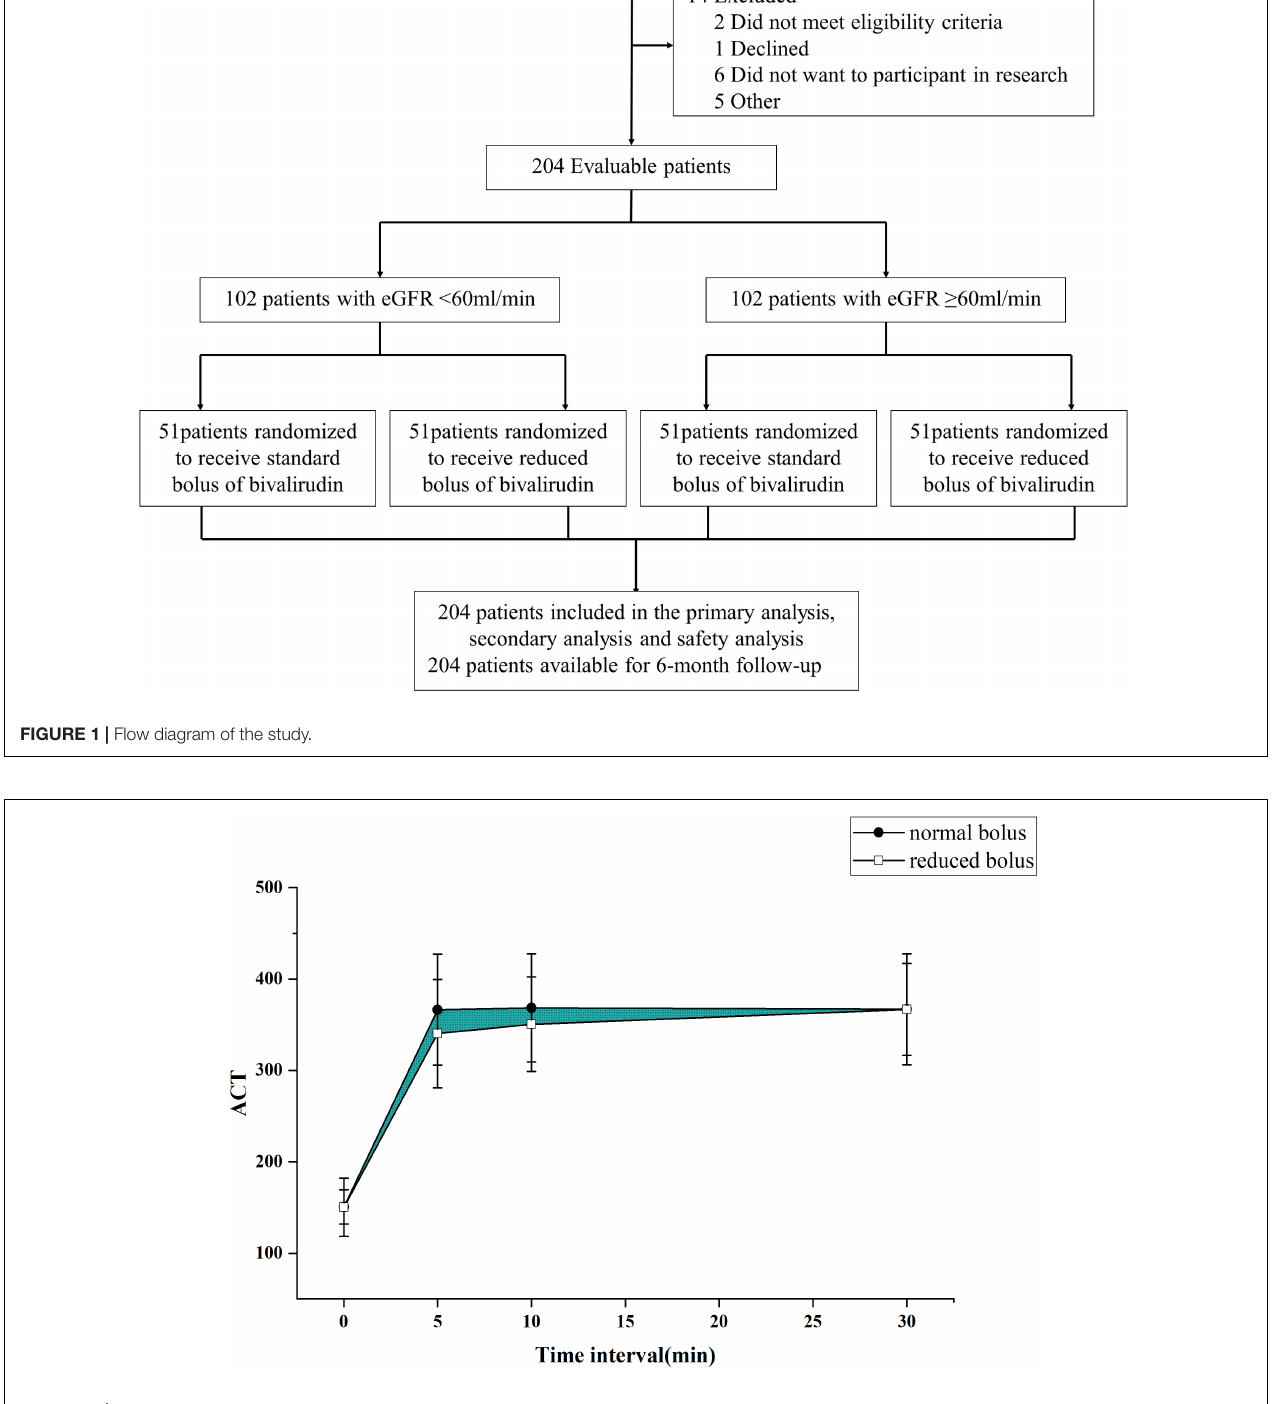
Frontiers in Cardiovascular Medicine |